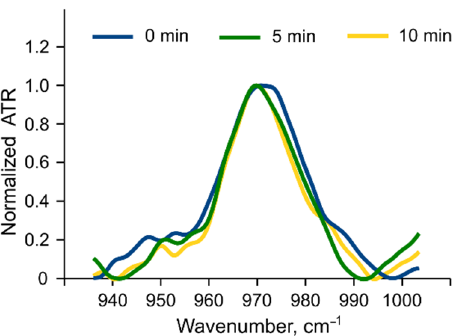
Figure 7. Normalized choline group peak in 10PI liposomes before (blue) and after albumin addition (green and yellow). FTIR spectra were recorded in PBS at 37 ◦ C, lipid concentration of 12 mM, and albumin concentration of 6 mg/mL.